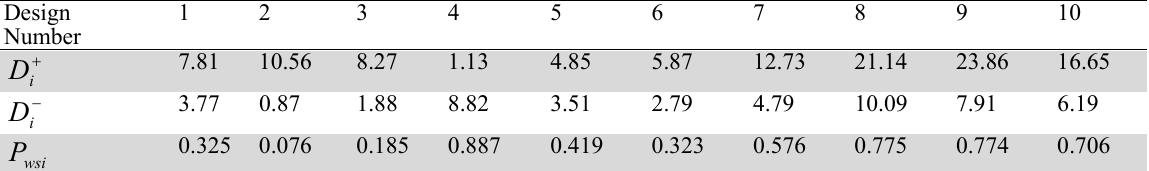
Relative closeness values of each alternative with ws-TOPSIS Design Number